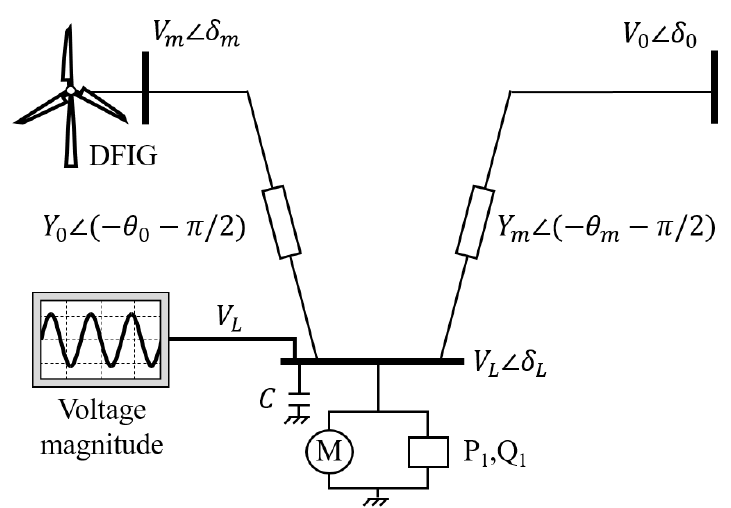
Figure 5. three-bus power system network with doubly fed induction generator (DFIG).